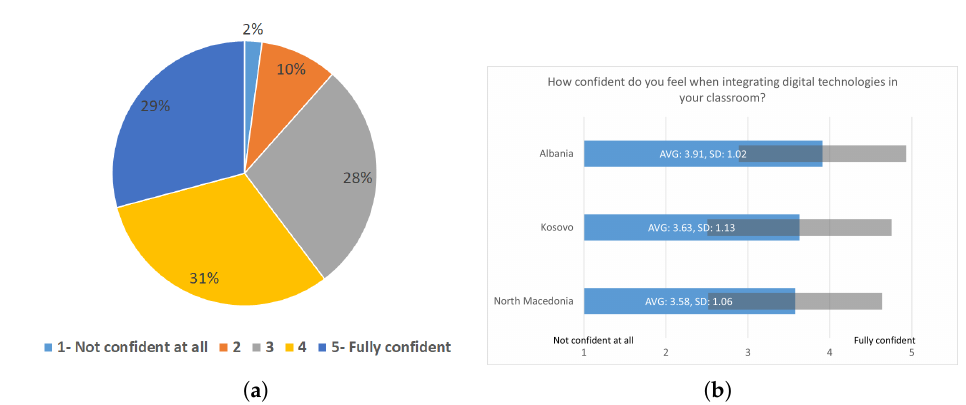
Figure 9. ( a ) Level of confidence in digital technology implementation in teaching. ( b ) Frequency of laboratory